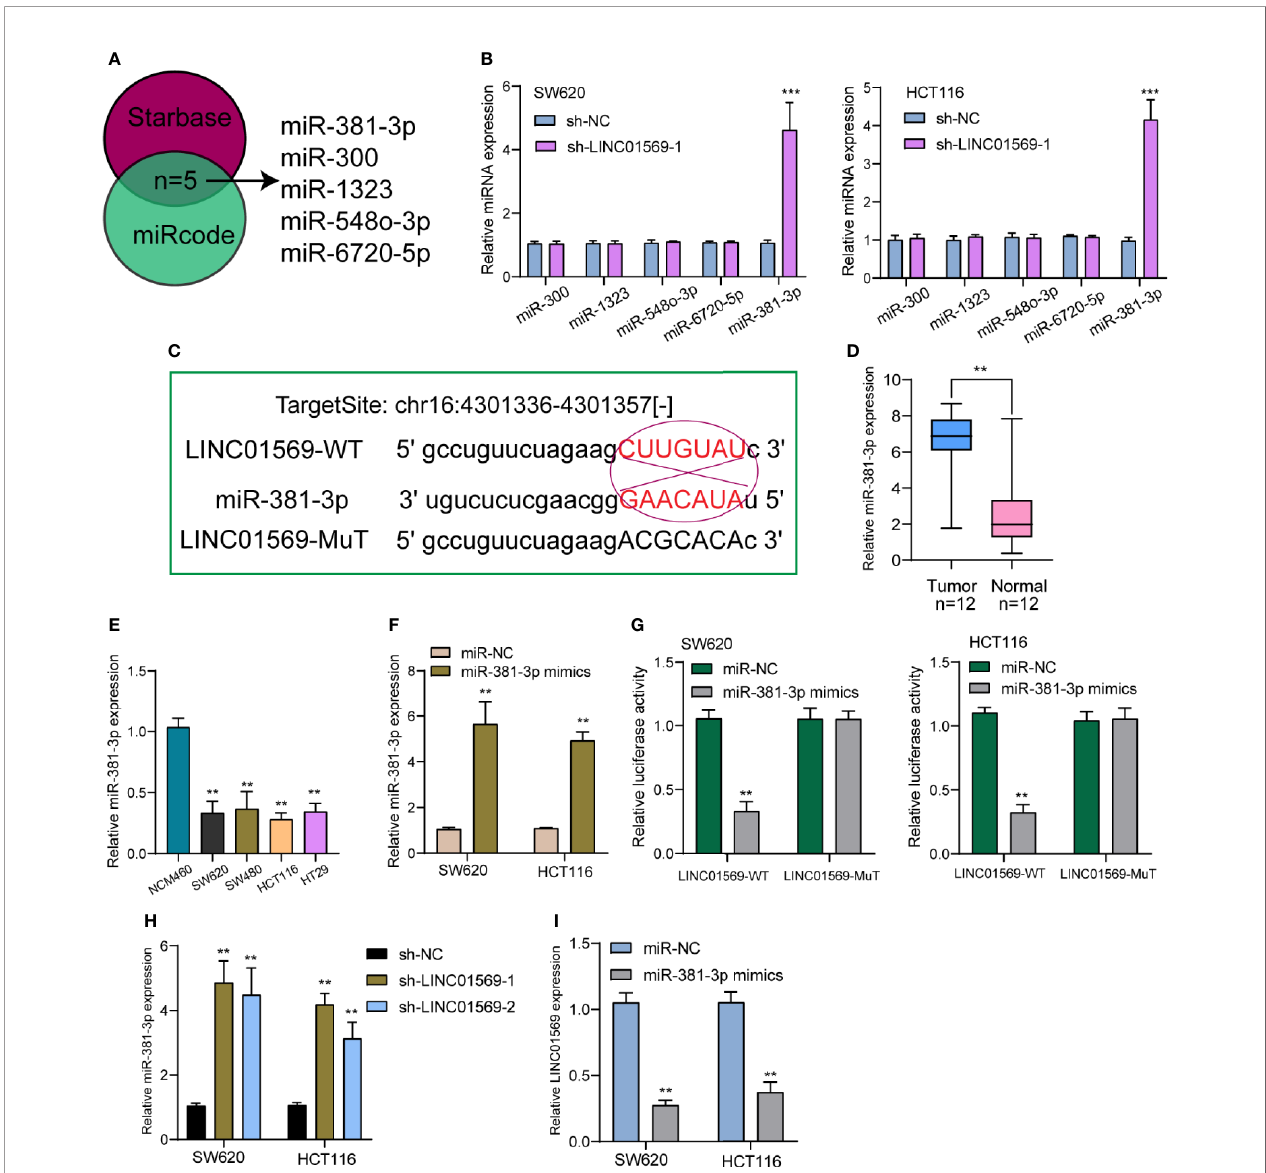
FIGURE 4 | MiR-381-3p served as a straight target of LINC01569. (A) Potential miRNAs that sponged LINC01569 were predicted using the Starbase 2.0 and miRcode. (B) The expression of the fi ve miRNAs in SW620 and HCT116 cells transfected with sh-NC or sh-LINC01569-1. (C) Starbase database projected an underlying adhesion area for LINC01569 together with miR-381-3p. (D) RT-PCR for the expression of LINC01569 in our patients. (E) miR-381-3p levels were decreased in four CRC cell lines. (F) The transfection ef fi ciency of miR-381-3p mimics was demonstrated in SW620 and HCT116 cells using RT-PCR. (G) The mutual effects of miR-381-3p and LINC01569 were displayed by luciferase reporter analysis. (H) The distinct downregulation of miR-381-3p was con fi rmed in SW62 and HCT116 cells transfected with sh-LINC01569-1 or sh-LINC01569-2. (I) miR-381-3p mimics inhibited the LINC01569 expression in SW62 and HCT116 cells. **P < 0.01, ***P <